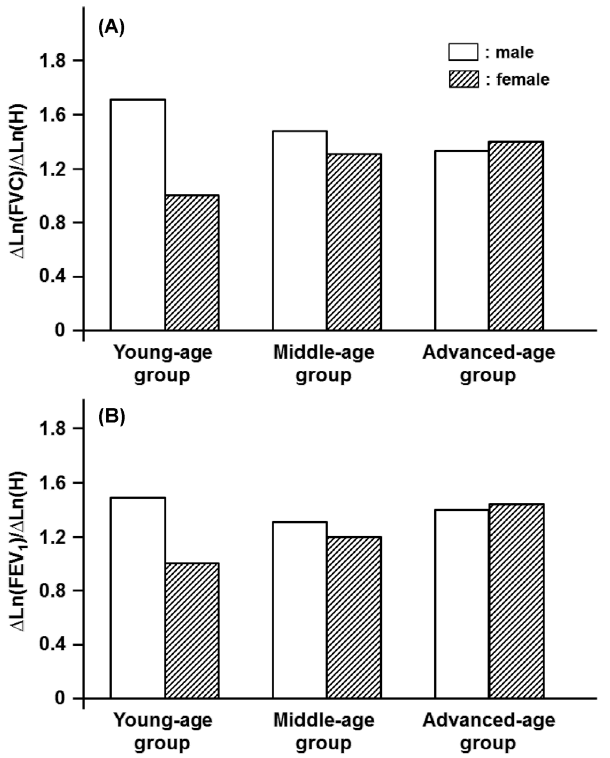
Figure 2. Age-specific impacts of height (H) on PEF and FEF 50 estimated for three different age groups of both men and women. (A): Partial regression coefficients of Ln(H) for reference means of Ln(PEF) in young-, middle-, and advanced-age groups of either gender. Partial regression coefficients of Ln(H) for D Ln(PEF) are defined as D Ln(PEF)/ D Ln(H). (B): Partial regression coefficients of Ln(H) for Ln(FEF 50 ) are defined as D Ln(FEF 50 )/ D Ln(H).